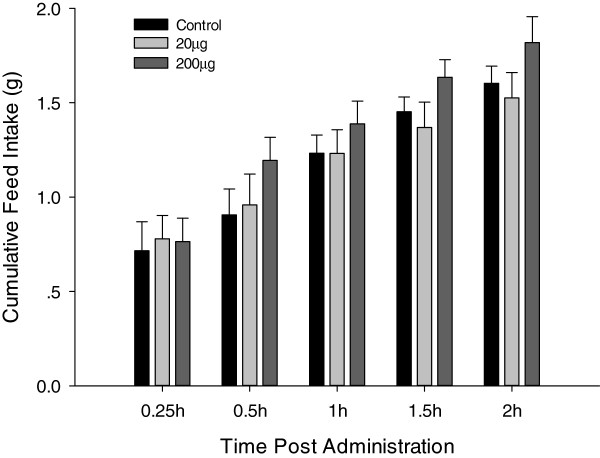
Cumulative Feed Intake of broiler chicks after ICV administration with saline (control, n = 8), 20 μg (n = 9) or 200 μg (n = 7) L-arginine, feed intake was recorded at 0.25, 0.5, 1, 1.5, and 2 h post-administration; Data are represented as means ± S.E.M.